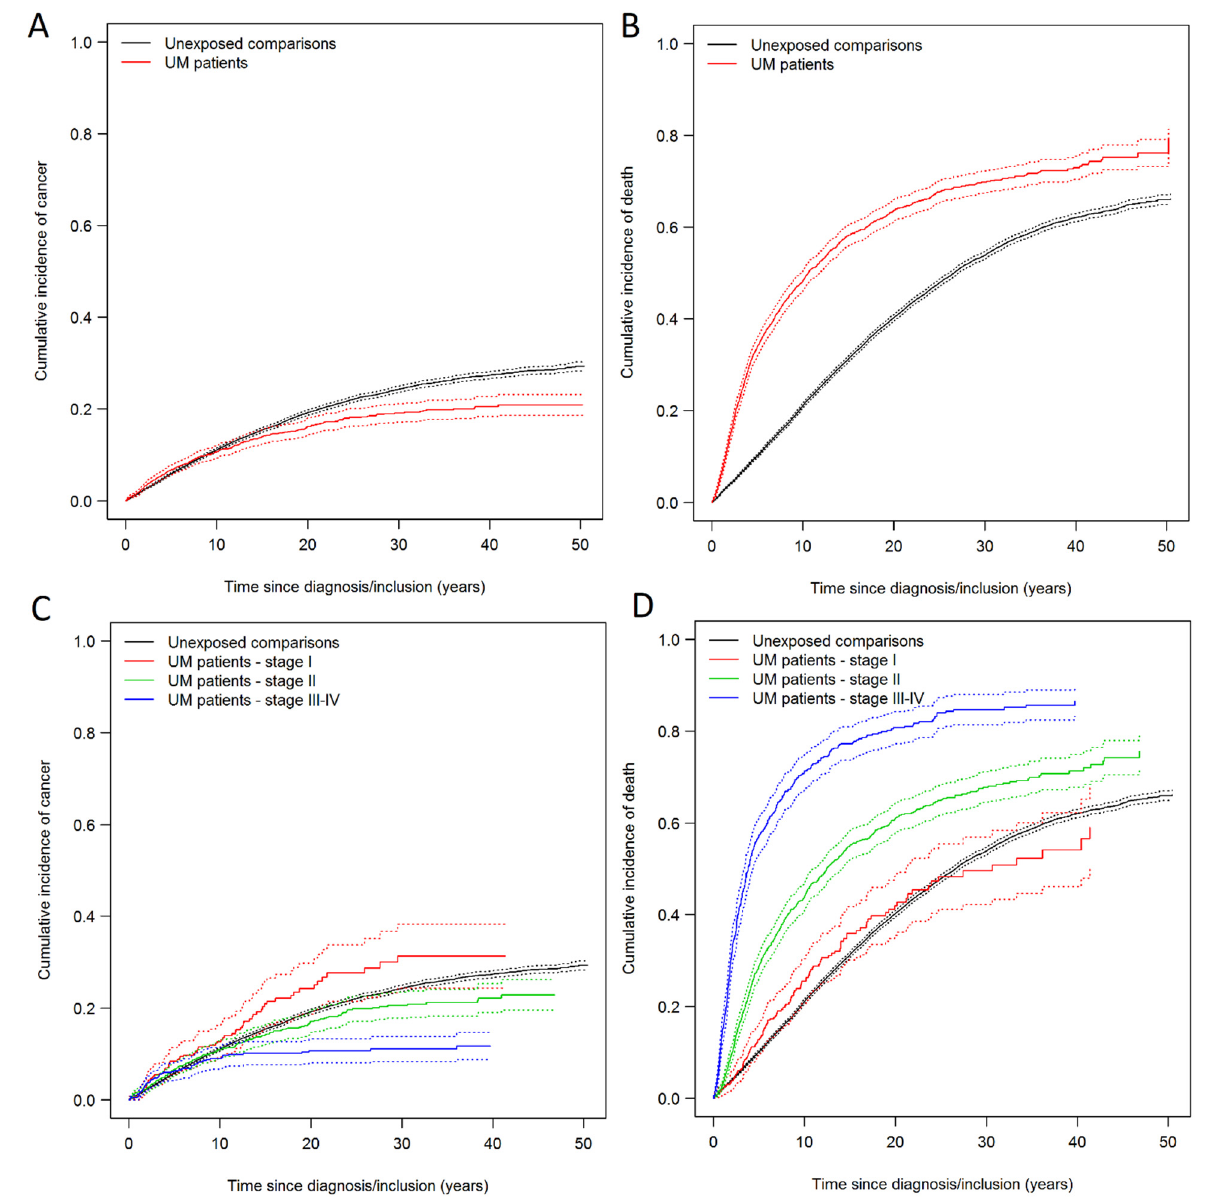
Figure 1. ( A ) Solid lines show the cumulative incidence of new primary cancer (all cancer types except posterior uveal melanoma and non-melanoma skin cancer (NMSC)) with death as a competing event. ( B ) Solid lines show cumulative incidence of death (all-cause). ( C ) Solid lines show cumulative incidence of new primary cancer (all cancer types except posterior UM and NMSC) with death (all-cause) as a competing event. Uveal melanoma patients stratified according to American Joint Committee on Cancer (AJCC) stage. ( D ) Solid lines show cumulative incidence of death (all-cause) stratified according to AJCC stage. Dotted lines shows the 95% confidence intervals.